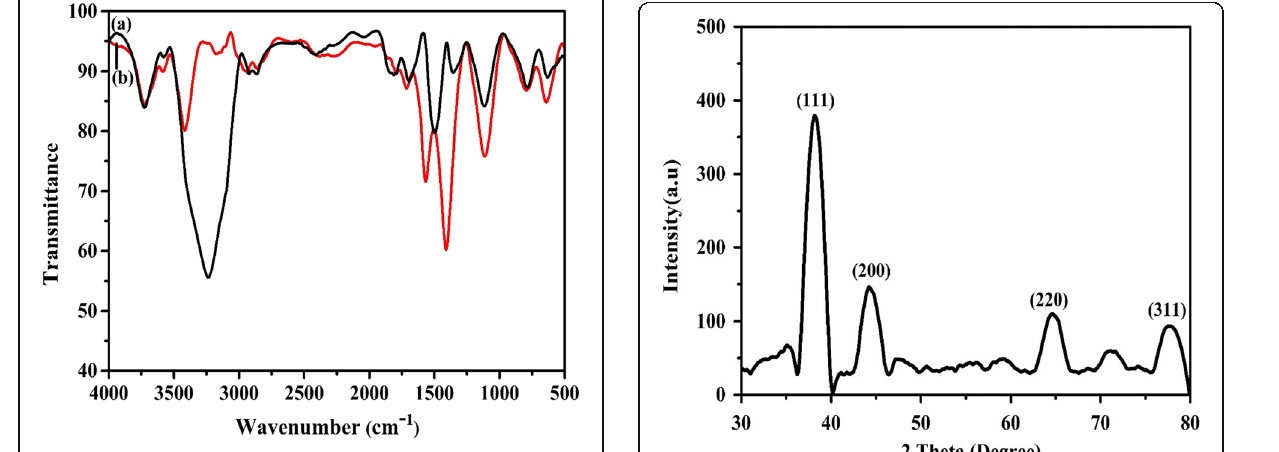
Fig. 3 FTIR spectra of ( a ) papaya leaf extract and ( b ) papaya leaf